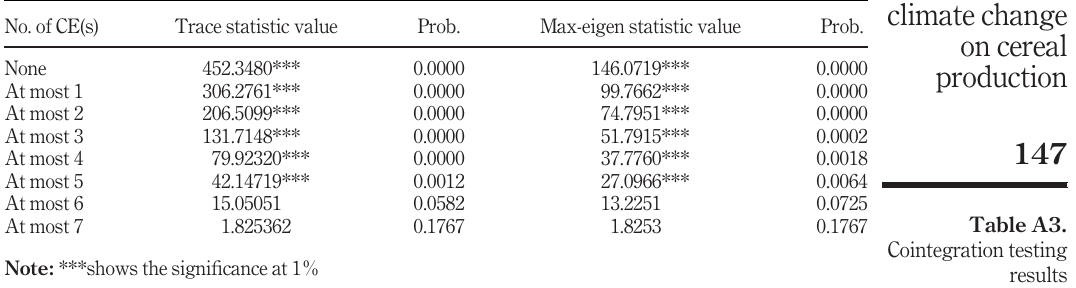
Table A3. Cointegration testing